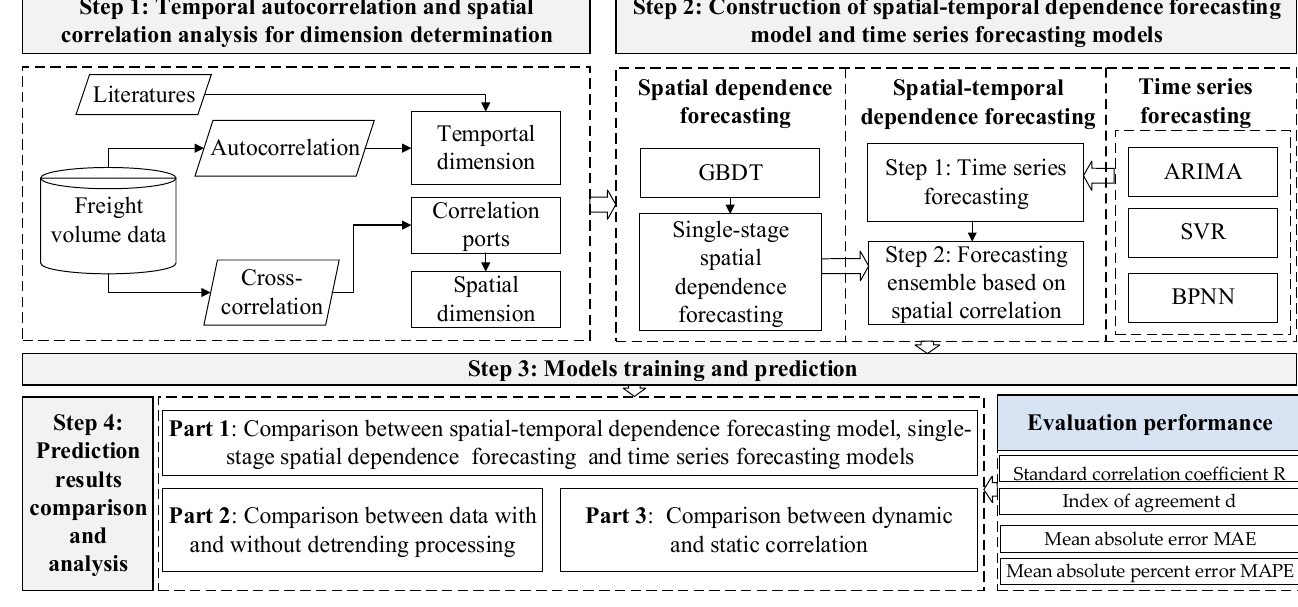
Figure 3. Framework for spatial-temporal dependence forecasting and analysis.